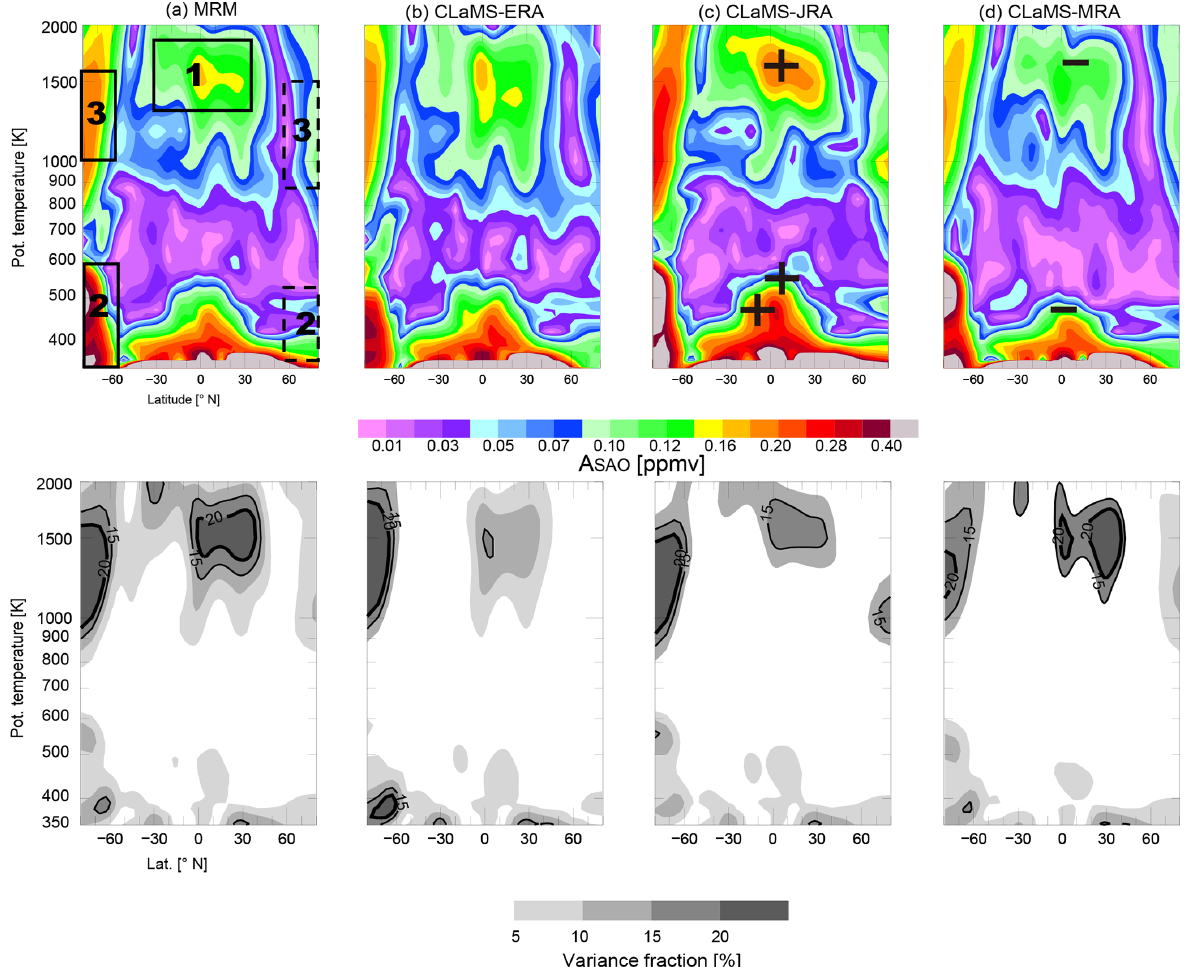
Figure C1. The top row shows SAH amplitudes in the same way as in the second row of Fig. 7. The bottom row shows the fraction of SAH variance relative to total variance, similar to the bottom row of Fig.